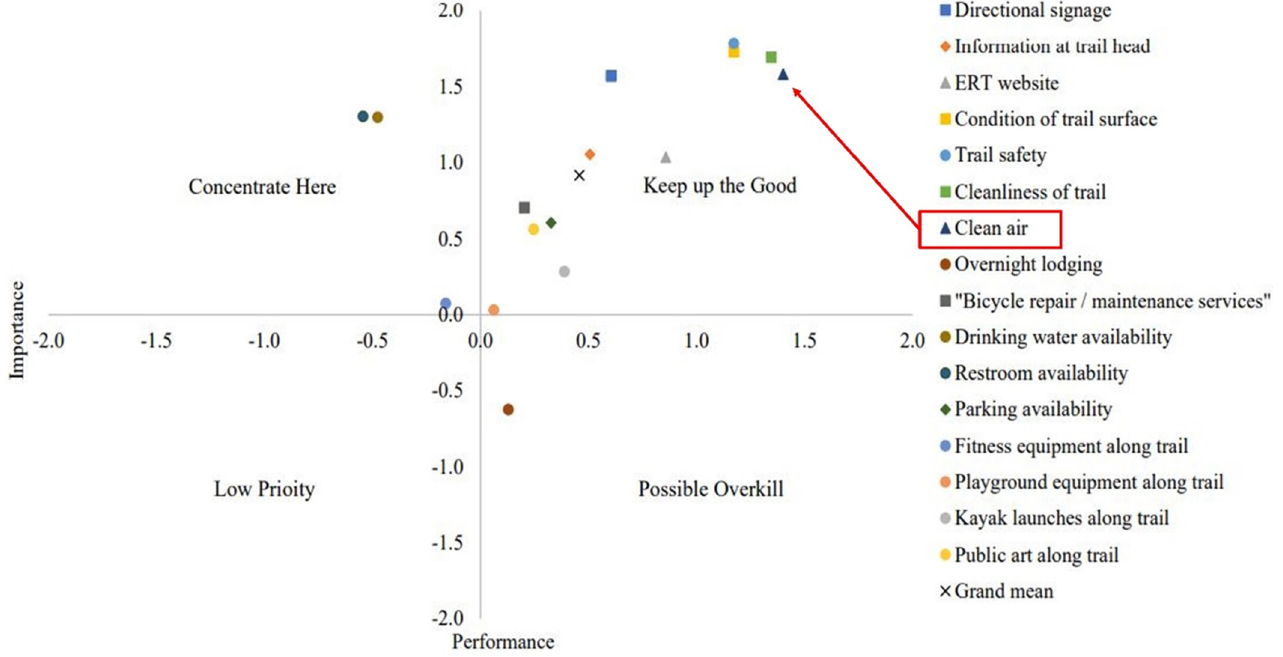
Figure 3. Importance Performance Matrix of Elizabeth River Trail amenities and services. Table 3. Regression analysis summary for IPA and PHORS predicting trail use.